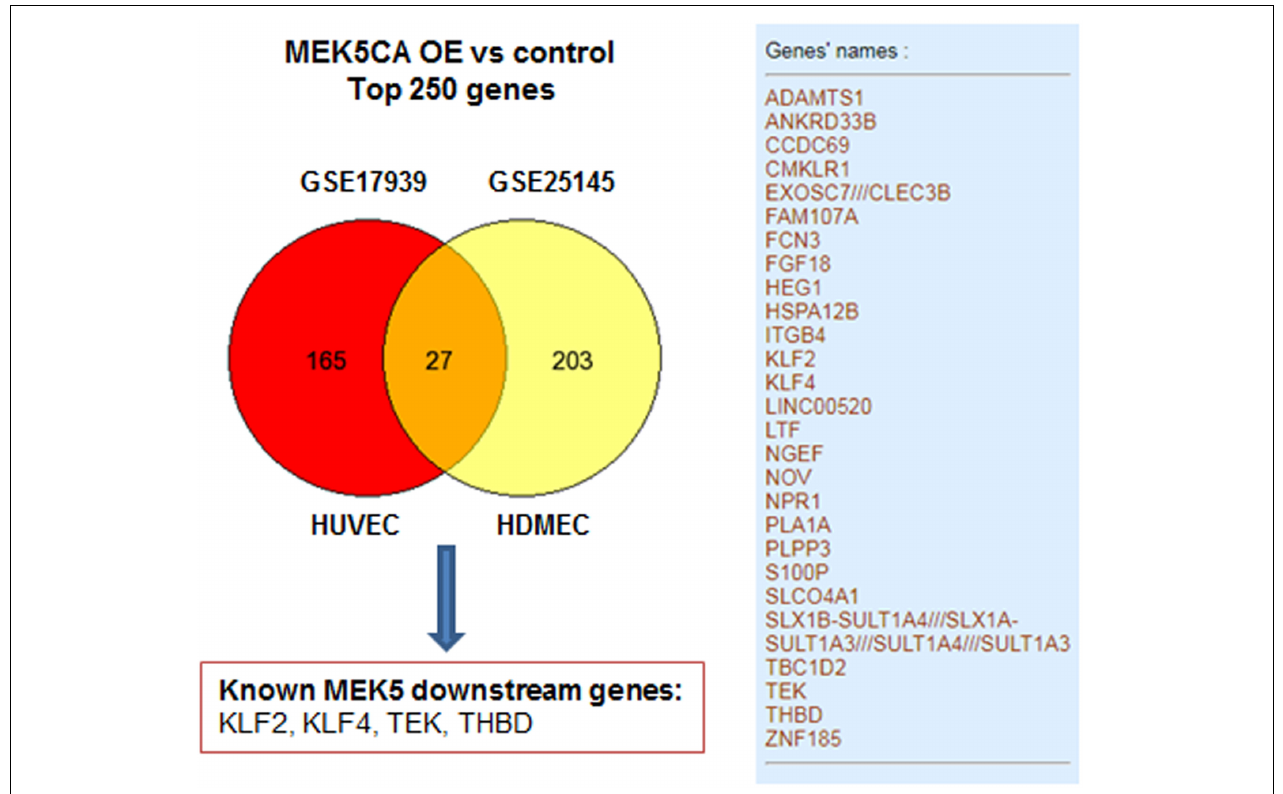
FIGURE 2 | An example of mining existing data from public repository GSE17939 (Ohnesorge et al., 2010) and GSE25145 (Clark et al., 2011). A full list of 27 common genes revealed by both datasets was presented in the right panel. Total number of genes was less than 250 which is due to missing annotations in both datasets. MEK5CA OE, overexpression of constitutively active MEK5 mutant; HUVEC, human umbilical vein endothelial cells; HEMEC, Human dermal microvascular endothelial